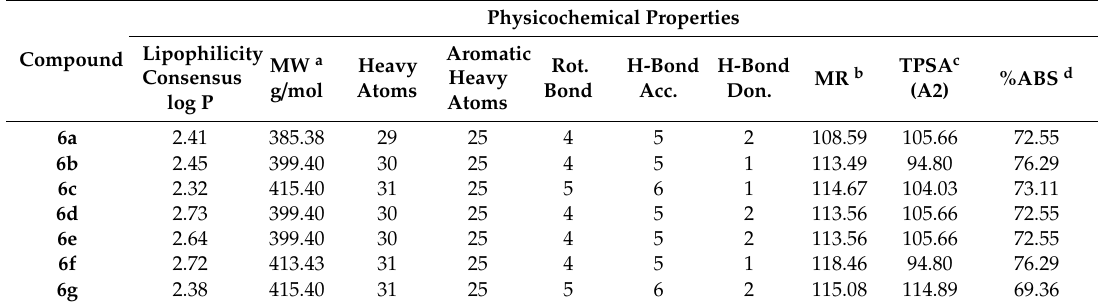
Table 5. Physicochemical and lipophilicity of the target compounds using Swiss absorption, distribution, metabolism, and excretion (ADME) and Molinspiration software.